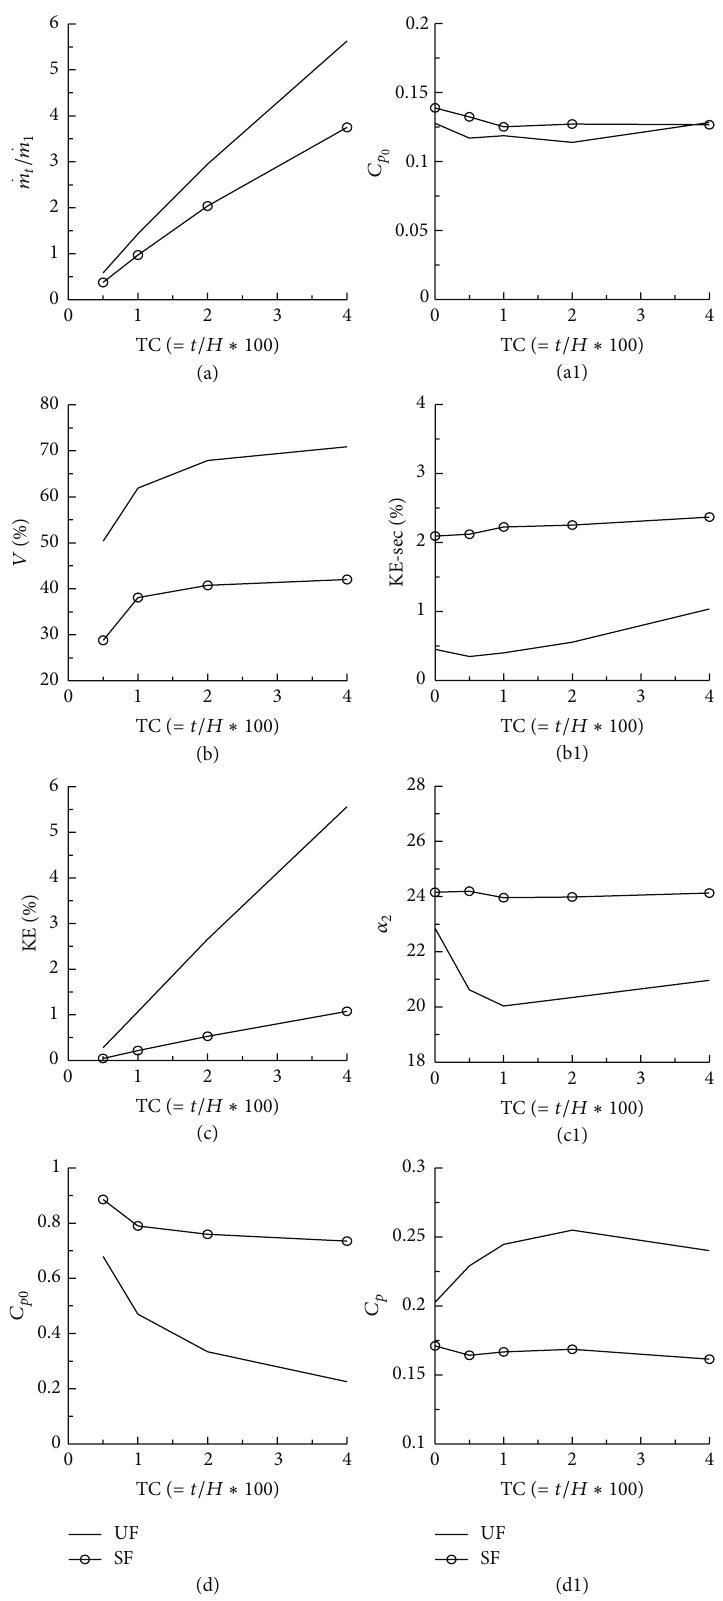
Figure 13: Overall effects in the tip gap region and wake, with reference to